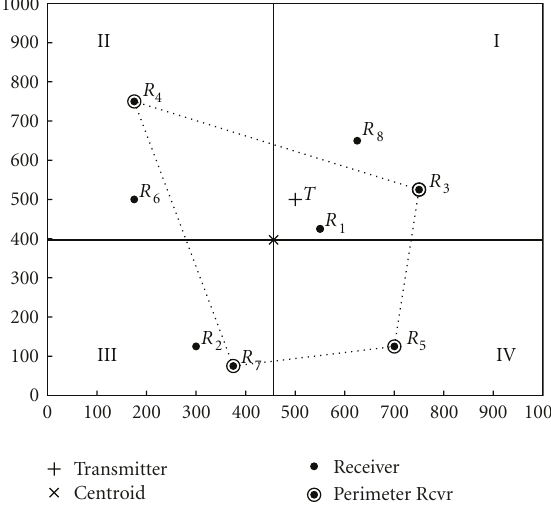
Algorithm 3 ( A γ : perimeter-pairs algorithm). The perimeter- pairs algorithm A γ partitions a transmitter’s radio range into four quadrants. Four perimeter receivers are determined.